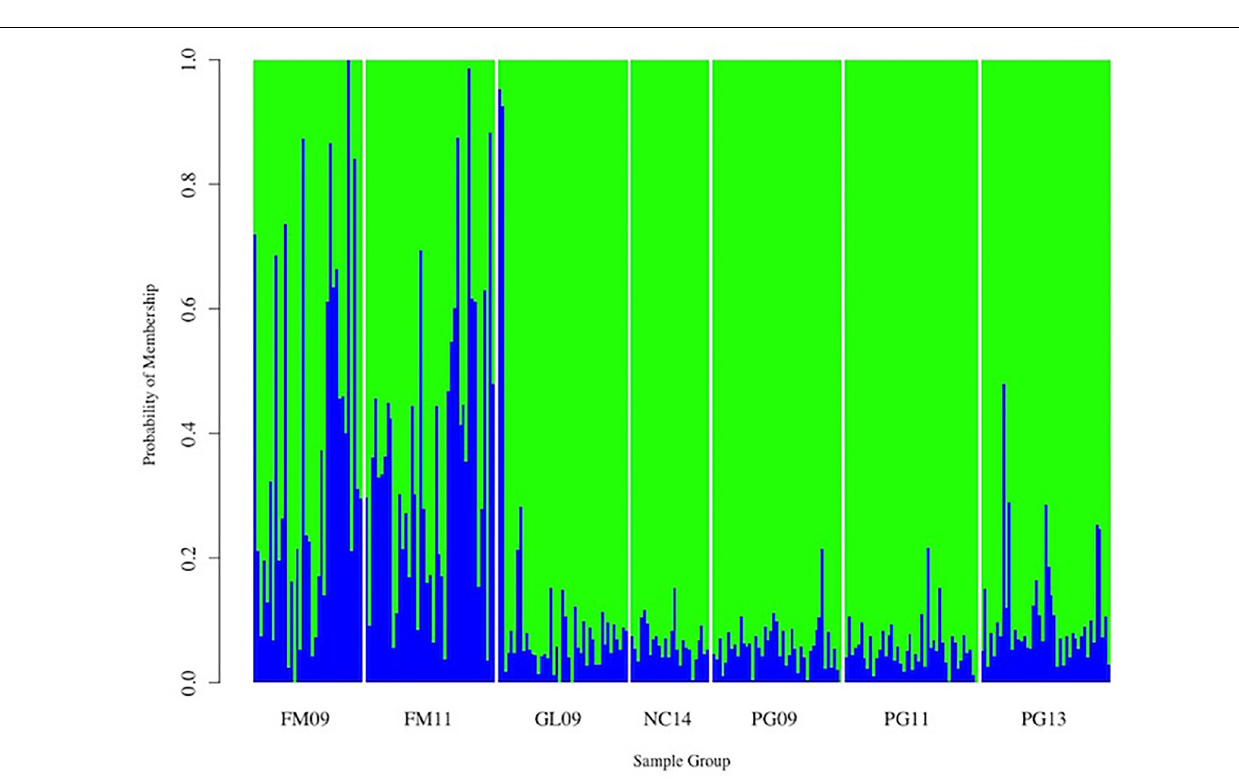
Frontiers in Marine Science |